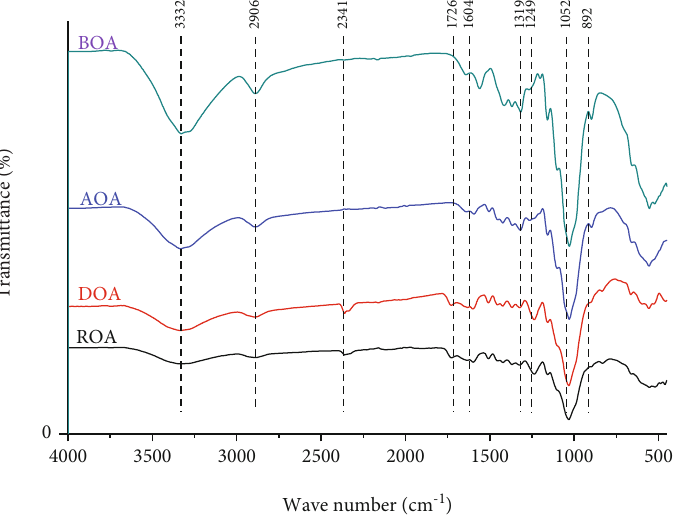
Figure 7: FTIR spectra of ROA, DOA, AOA, and BOA.